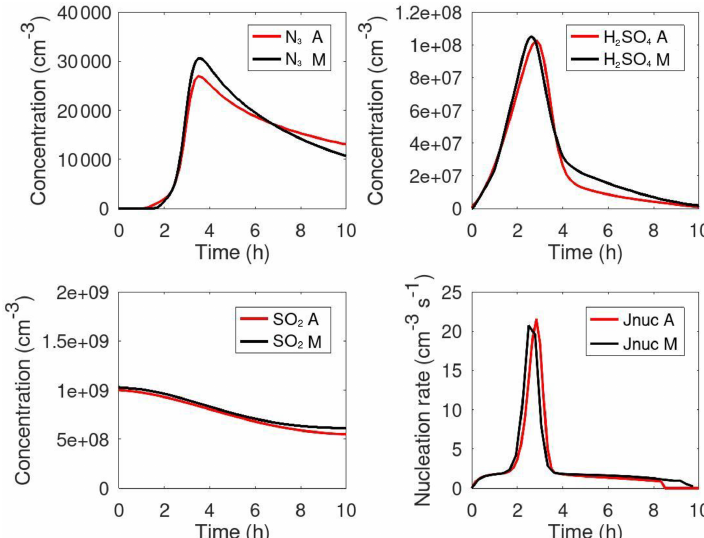
Figure G2. Comparison of modelled total particle number with diameter > 3nm ( N 3 ), gas-phase concentrations of H 2 SO 4 and SO 2 , and nucleation rate from MAFOR v2.0 (black lines) and AEROFOR (red lines) in a test of the new nucleation parameterization M2018 for new particle formation under clear-sky conditions ( T = 267K, RH = 90%). The simulations started at 8:00 local time.